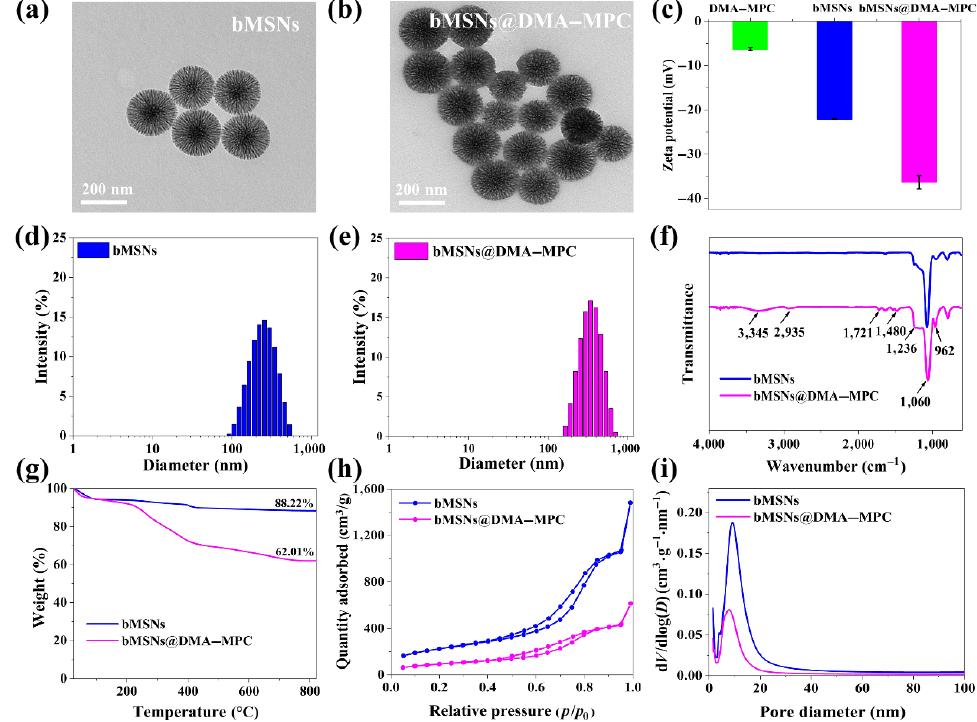
Fig. 3 Characterizations of the bMSNs and bMSNs@DMA–MPC (1:4) nanoparticles. TEM images of (a) bMSNs and (b) bMSNs@DMA–MPC. (c) Zeta potentials of DMA–MPC, bMSNs, and bMSNs@DMA–MPC. Histogram distributions showing the hydrodynamic diameters for (d) bMSNs and (e) bMSNs@DMA–MPC in aqueous medium at 25°C. (f) FTIR spectra, (g) TGA curves, (h) N 2 adsorption–desorption isotherms, and (i) pore size distributions of bMSNs and